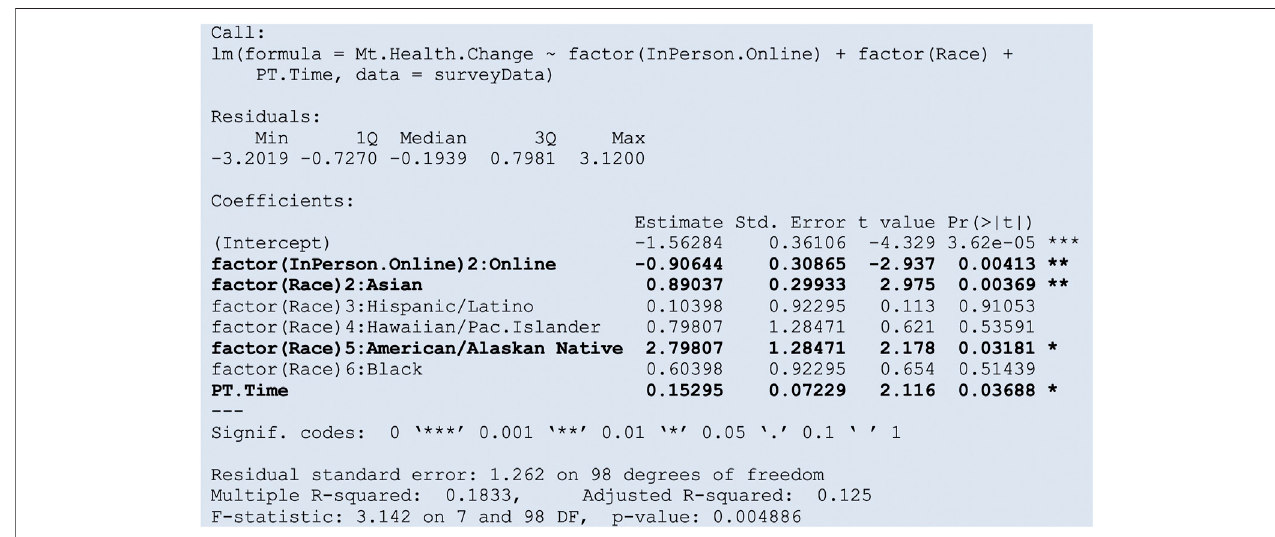
FIGURE 7 | Regression results from best fi tting generalized regression model. The best fi tting regression model was determined using R statistical software which identi fi es parameters that minimize AIC.